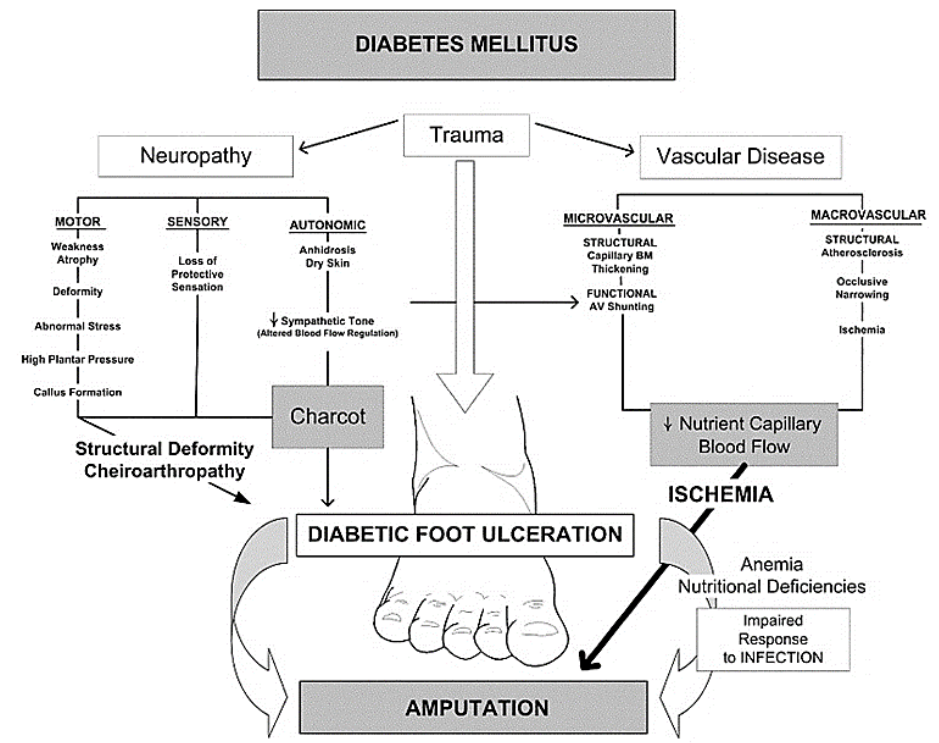
Figure 2. Pathophysiology of DFU. Reproduced from [7], with permission from Elsevier, 2006.